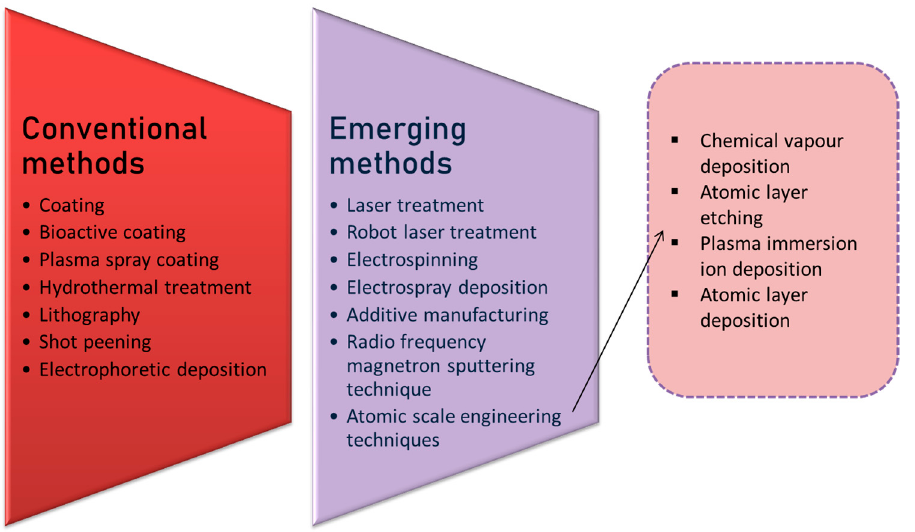
Figure 12. Diagrammatic illustration of commonly used conventional and emerging surface engineering techniques, which include coating, lithography, laser treatment, hydrothermal treatment, plasma spraying, plasma immersion ion deposition, radio frequency magnetron sputtering technique, chemical vapour deposition, atomic layer deposition, electrospray deposition, and electrospinning deposition.